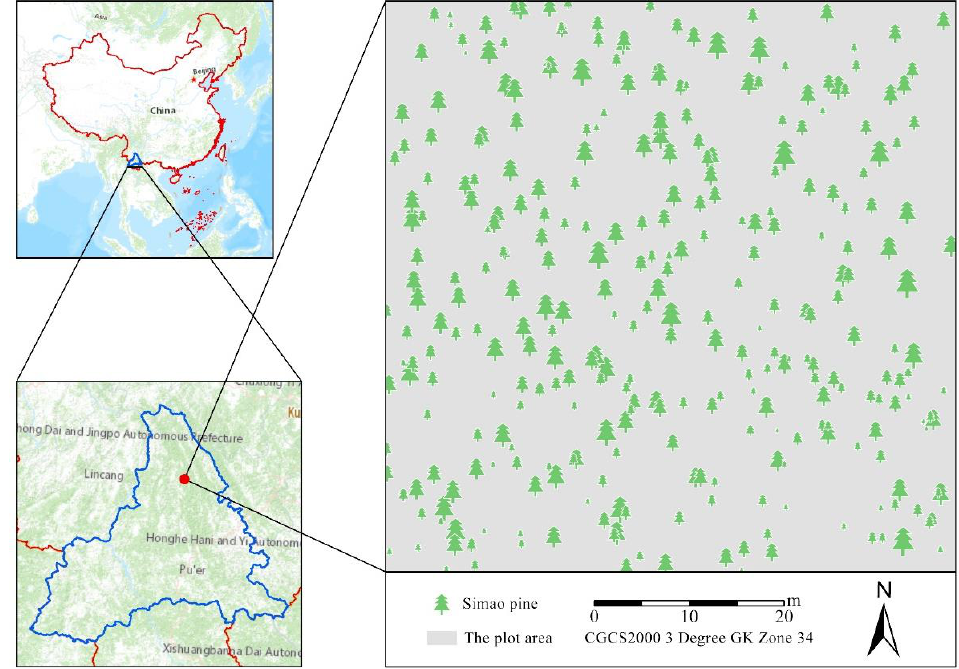
Figure 1. The location distribution of Simao pines in the plot. The tree icons ’ different sizes indicate the DBH ’ s relative size.